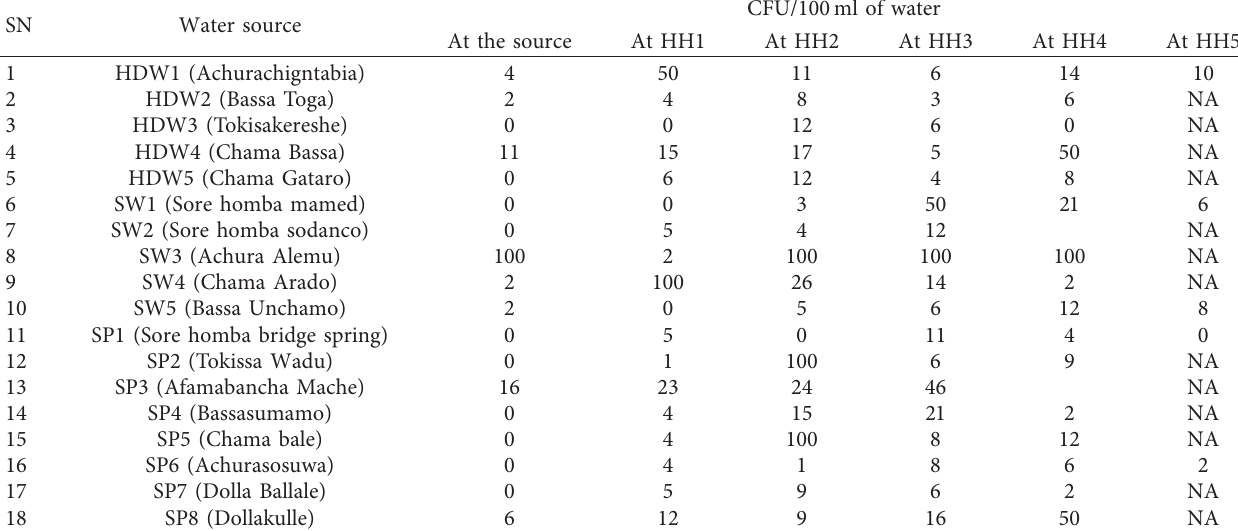
Table 4: Water quality analysis results per water scheme and households (100ml sample).